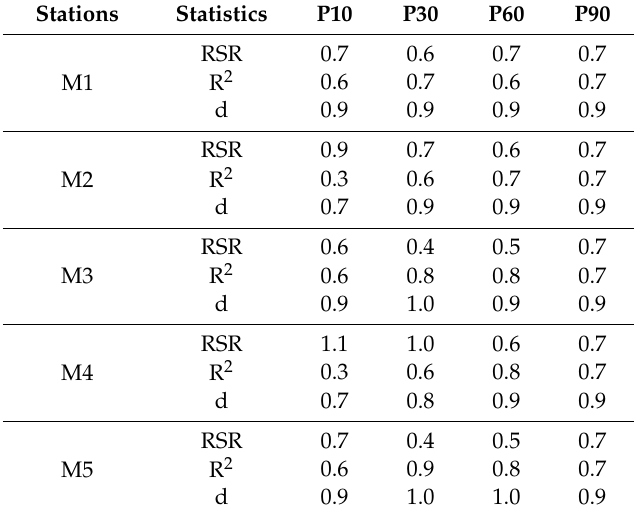
Table 5. Advanced delta change model validation